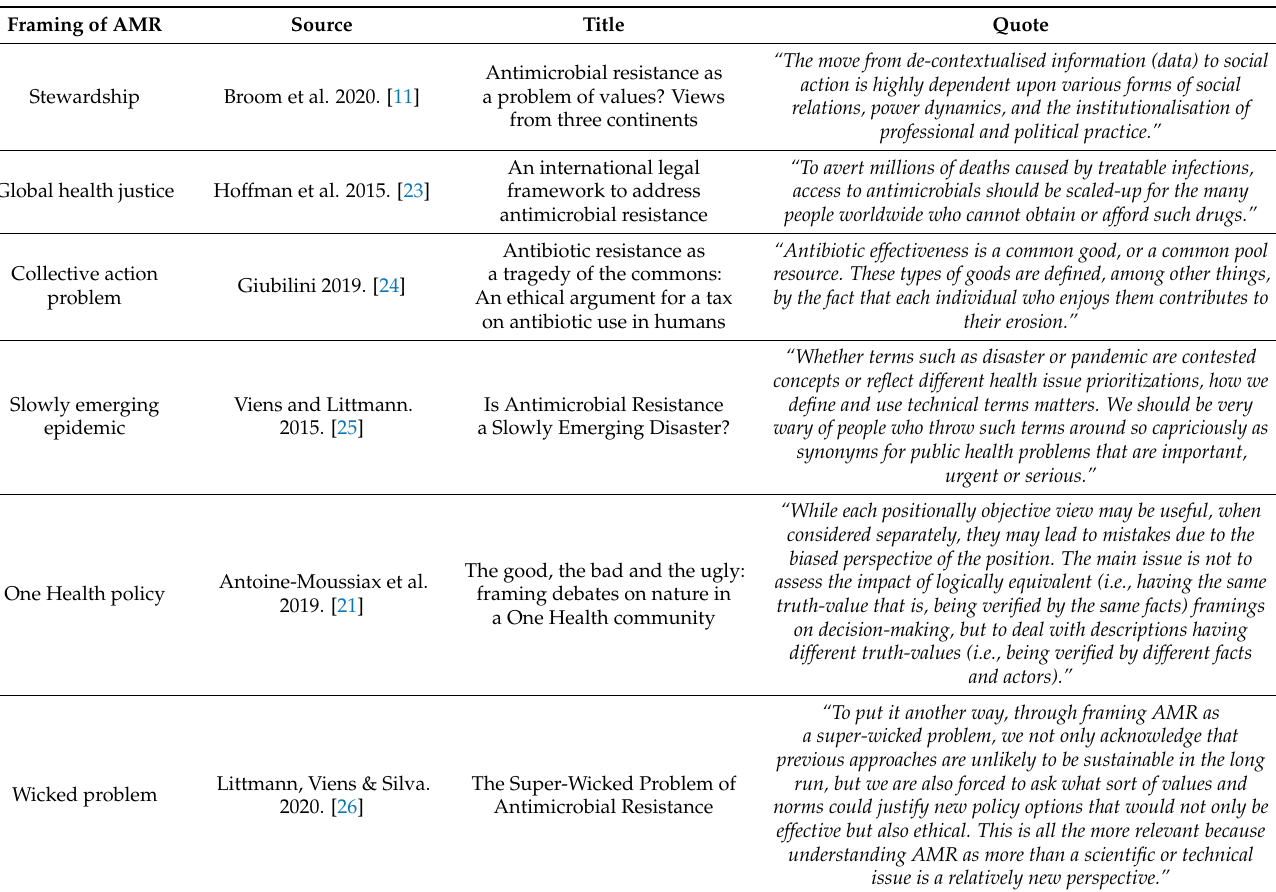
Table 1. Recent Work Reframing The Challenge of Antimicrobial